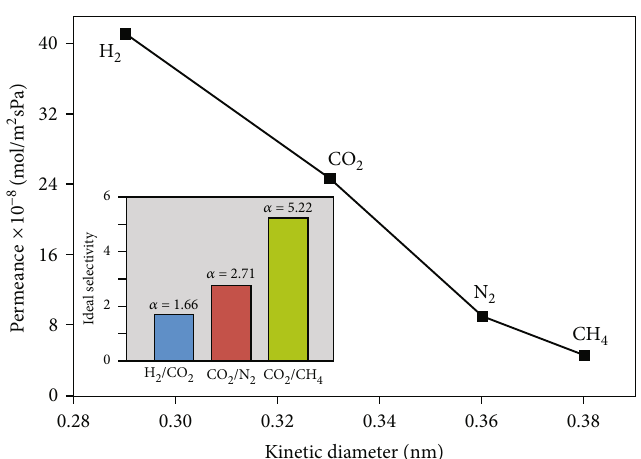
Figure 2: Single gas permeation results of small molecular gas over DDR3 membrane at room temperature and feed pressure of 2 bar (inset: ideal selectivities for H